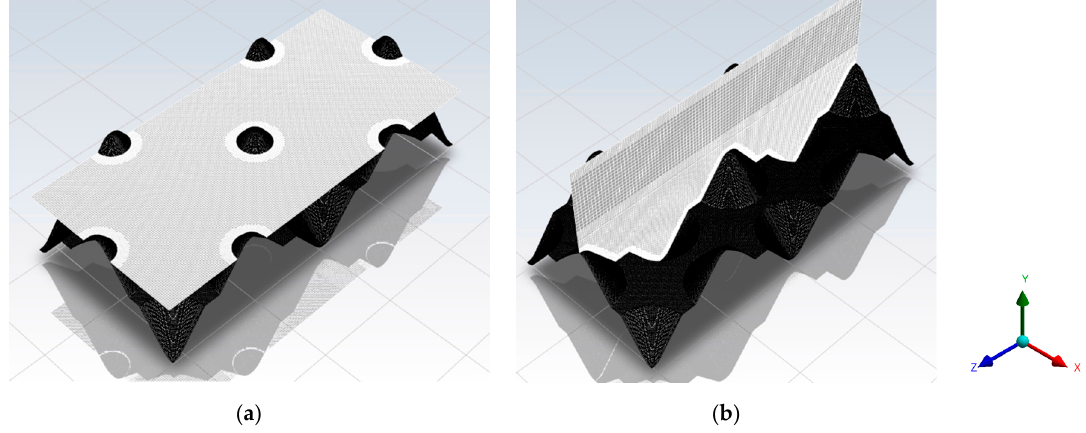
Figure 5. The snapshot planes. ( a ) horizontal and ( b ) stream-wise wall normal planes.